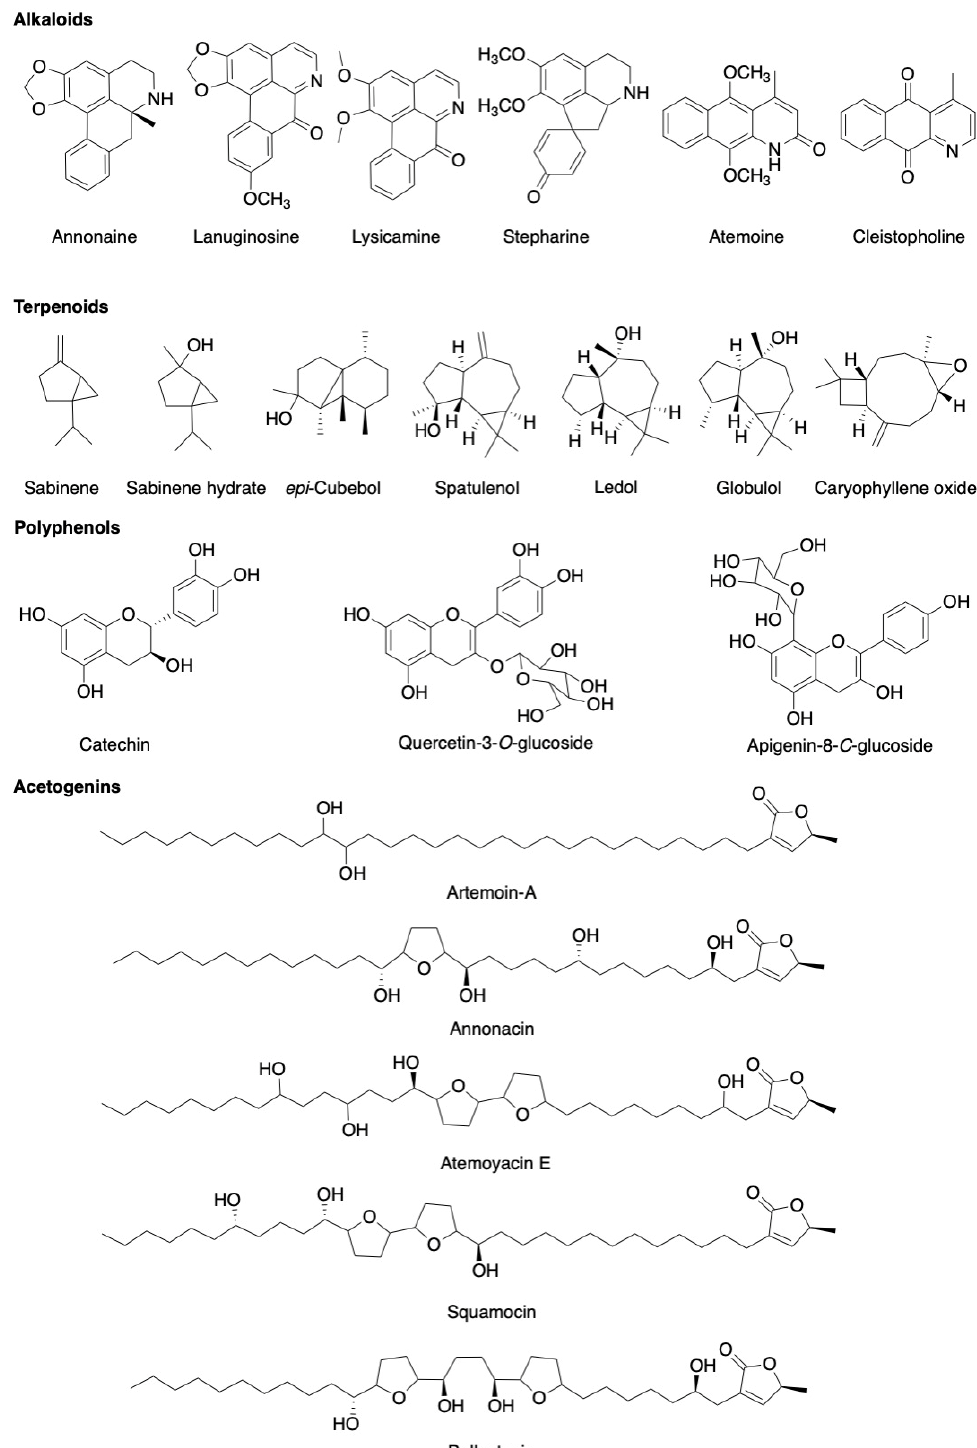
Figure 2. Structures of some representative phytochemical constituents of Annona atemoya .